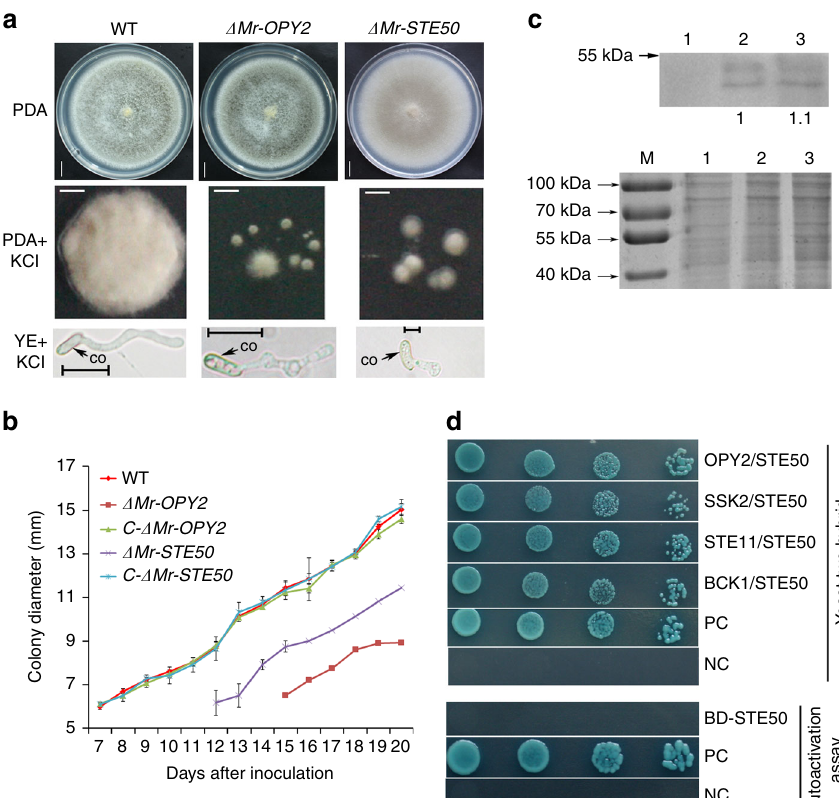
Fig. 5 Colony phenotypes and osmotic stress tolerance of Δ Mr-OPY2 , Δ Mr-STE50 and WT. a Upper panel: colonies of the strains on PDA (Scale bar represents 10 mm). Middle panel: colonies on PDA plus 0.75 M KCl (scale bar represents 1 mm). Lower panel: bright fi eld images of individual germlings in YE (0.01% yeast extract) plus 0.75 M KCl (Scale bar represents 10 μ m). Colony pictures were taken 18 days after inoculation. Germling pictures were taken 16 h after inoculation. b Growth curves of the strains on PDA plates plus 0.75 M KCl. Growth assays were repeated three times with three replicates per repeat. Data are expressed as the mean ± SE. Note: growth of Δ Mr-OPY2 and Δ Mr-STE50 was greatly reduced. c Upper panel: Western blot analysis of Mr-OPY2 protein levels in Δ Mr-OPY2 grown in SDY (1), WT grown in SDY (2) and in SDY plus 0.75 M KCl (3). The band intensity of WT in SDY is set at 1, and WT in SDY with KCl is relative to it; Δ Mr-OPY2 is a negative control. Lower panel: a portion of the loading control gel (for the western blot analysis in the upper panel) stained with Coomassie Brilliant Blue. M: Protein ladder. The uncropped images of the Western blot and the SDS-PAGE gel are shown in Supplementary Fig. 13. d Upper panel: yeast two-hybrid con fi rmation of the physical interaction of Mr-SET50 with Mr-OPY2 and three MAPKKK proteins (SSK2, STE11 and BCK1). Colonies were grown in SD-His-Ade-Leu-Trp + X- α -gal + AbA (Takara, Dalian China). NC: negative control (yeast cells containing the plasmid pGADT7-T and pGBKT7-Lam). PC: positive control (yeast cells containing the plasmid pGADT7-T and pGBKT7-53). Lower panel: Mr-STE50 lacks autoactivation activity. Y2HGold cells with pGBKT7-Mr-STE50 cannot grow in SD-His-Trp-Ade + X- α -gal (Takara, Dalian China). NC and PC are the same as those in the upper panel. Images are representative of at least three independent experiments for each condition P683-Mr-OPY2 and P404-Mr-OPY2 in their tolerance to oxida- tive stress, high osmotic stress and Congo red (Supplementary Fig. 8). Mr-OPY2 controls phosphorylation levels of MAPKs . The S. (1 mg ml − 1 ) produced no signi fi cant ( P > 0.05, Tukey ’ s test in cerevisiae OPY2 protein regulates the phosphorylation level of MAPKs by complexing with the adaptor protein STE50p that in turn interacts with three MAPKKK proteins 26 . We used yeast two-hybrid assays to con fi rm that the M. robertsii Mr-OPY2 physically interconnects with MAA_02467, the M. robertsii ortholog of STE50p (designated Mr-STE50), and thereafter the three MAPKKK proteins Mero-Ste11, Mero-Ssk2 and Mero-Bck1 (Fig. 5d). We disrupted Mr-STE50 to produce Δ Mr- STE50 , which was complemented with its genomic clone to produce C- Δ Mr- STE50 . Con fi rmation of gene disruption and mutant com- plementation is shown in Supplementary Fig. 2. Δ Mr-STE50 produced greyish green conidia compared with the darker green conidia of WT colonies (Fig. 5a). Δ Mr- STE50 had reduced tol- agent Congo Red (Supplementary Fig. 7), but its tolerance to NATURE COMMUNICATIONS | 8: